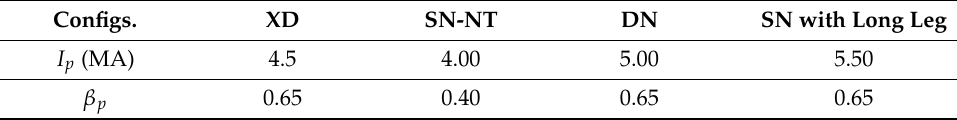
Figure 10. Plasma shapes at SOF of alternative configurations of the DTT device: ( a ) XD at 4.5 MA; ( b ) SN-NT at 4 MA; ( c ) DN at 5 MA; ( d ) SN with long leg at 5.5 MA. Table 9. Main plasma parameters of the DTT alternative configurations.